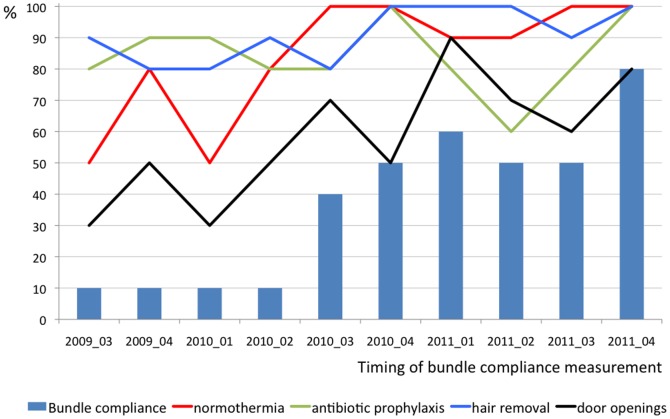
Compliance with the bundle and its individual components in repeated measurements from June 2009 through October 2011.